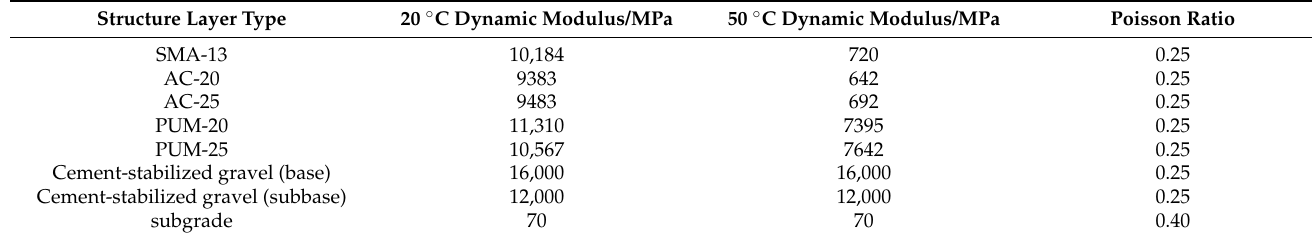
Table 4. Material parameters of each pavement structure layer.